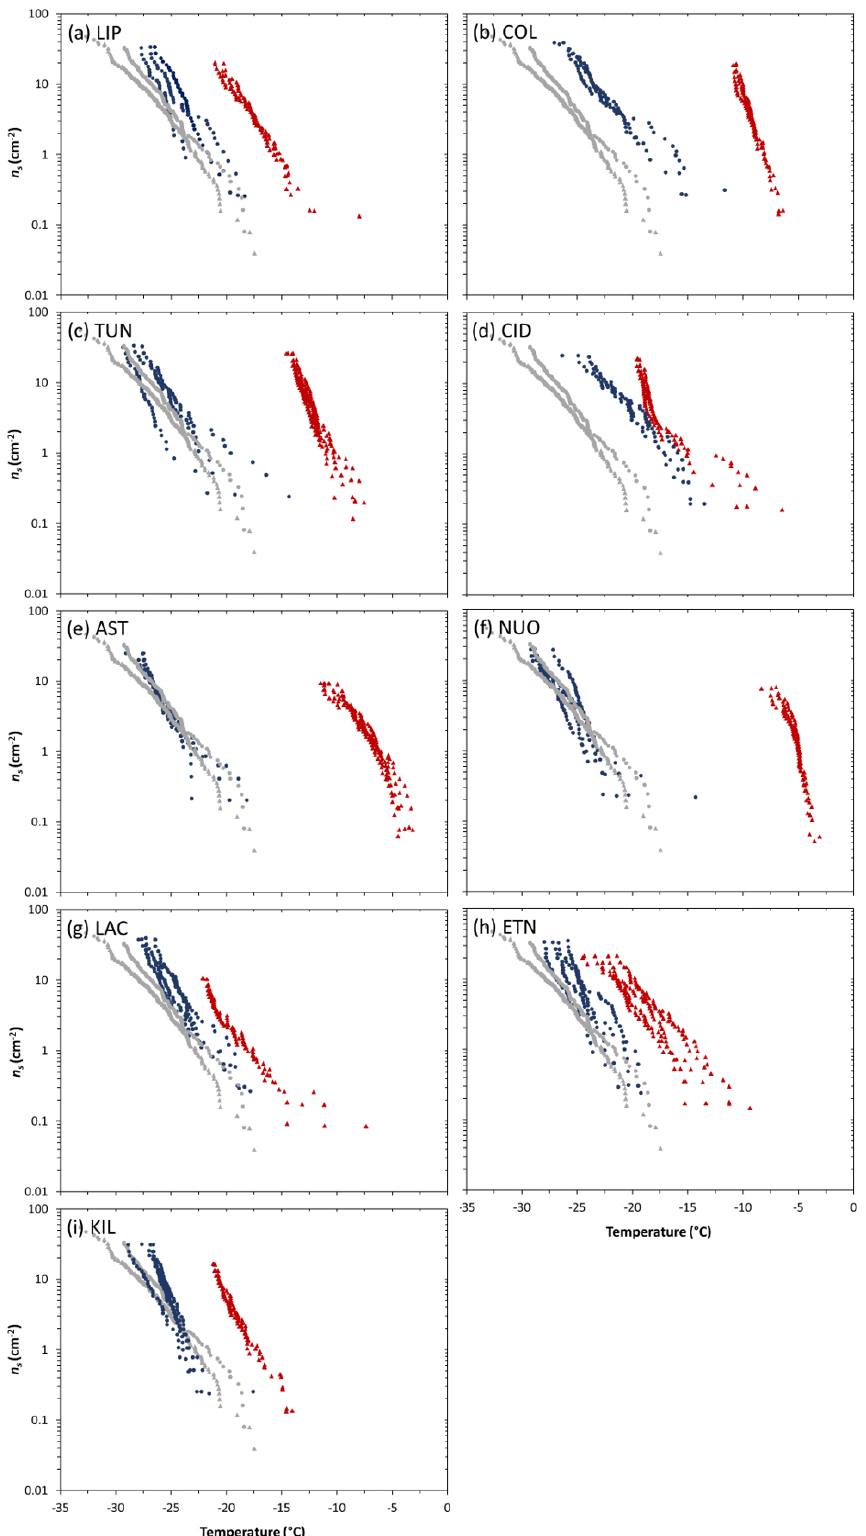
Figure 3. Ice-nucleation-active site density ( n s ) as a function of temperature for 1wt% suspensions of tephra or glass in water. Each plot shows replicates of a compositionally analogous pair of tephra (red triangles) and glass (blue circles). The grey curves with triangle and circle symbols represent the detection limit for n s (T ) based on the background water runs accompanying the tephra and glass experiments, respectively (see Fig. 2 caption for details). Sample codes are listed in Table